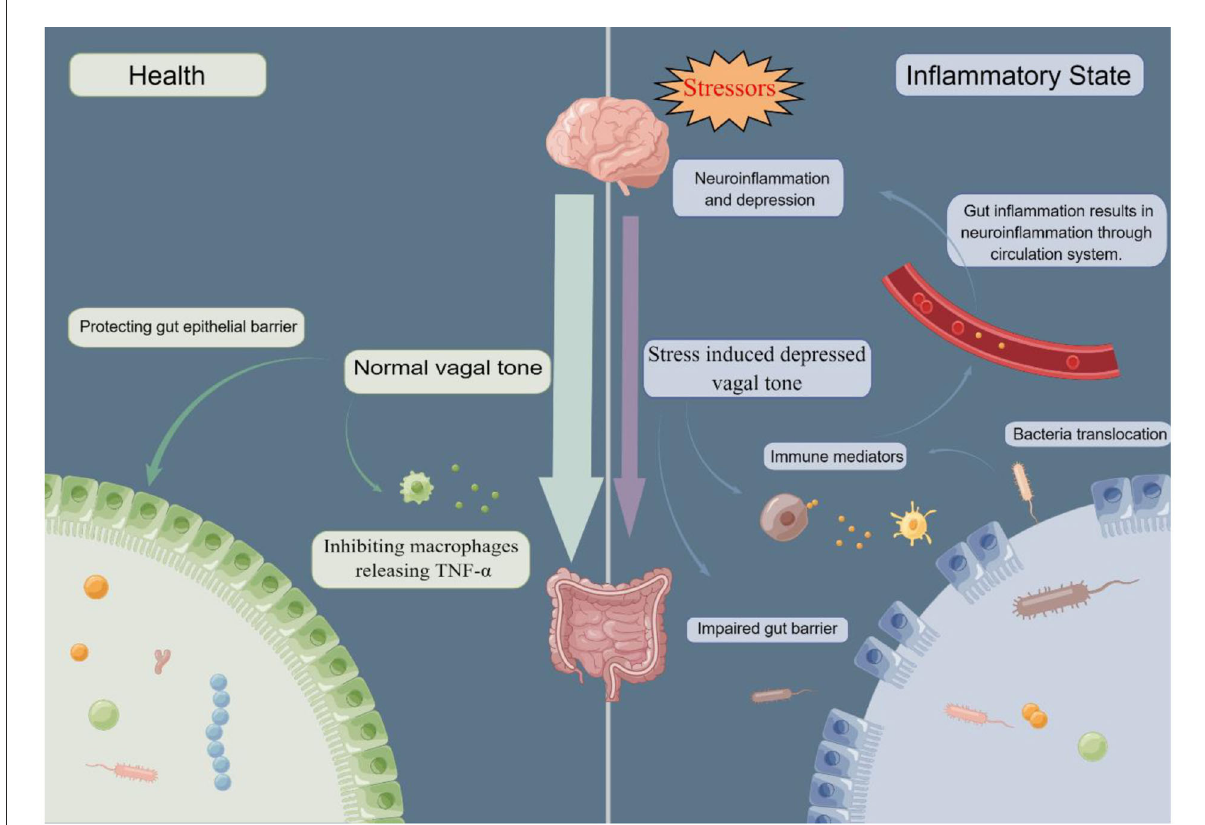
FIGURE2 In healthy conditions, normal vagal tone can protect gut barrier and inhibit macrophages releasing pro-cytokine, TNF- α . While in response to stressors, vagal tone is depressed, promoting gut barrier impairment and releasing of TNF- α . Compromised gut barrier facilitate bacterial translocation, which activates immune system and induces immune mediators. Through the circulation system, gut and system inflammation ultimately results in neuroinflammation. TNF- α , tumor necrosis factor alpha. By